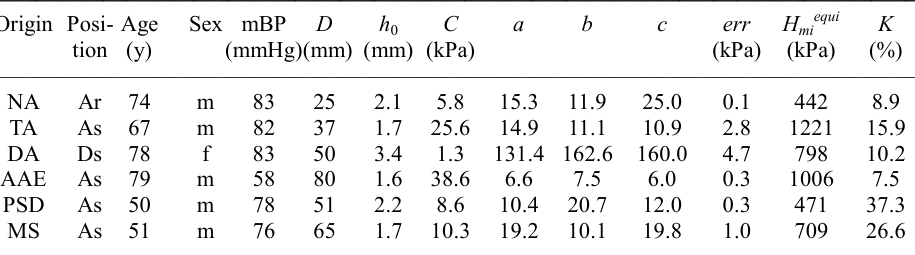
Fig. 2 Examples of specimens after stretch (a) and histological sections stained with Elastica-Masson (b). Black squares in (a) are the benchmarks on the luminal surface. Luminal side faces downward in (b). See legend to Table 2 for abbreviations. Dimensions and material constants of a representative specimen of each origin along with age, sex, and blood pressure of their